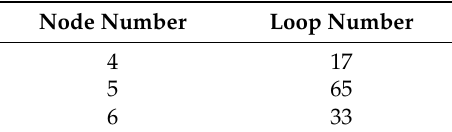
Table 7. Loops distribution.